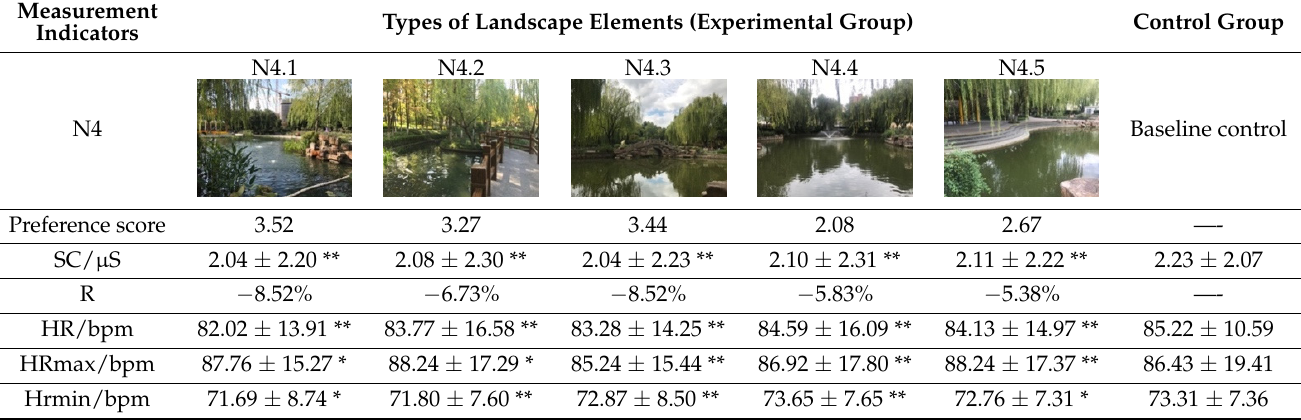
Table 10. Physiological indicators of participants before and after the measurement in response to different waterscape spaces.